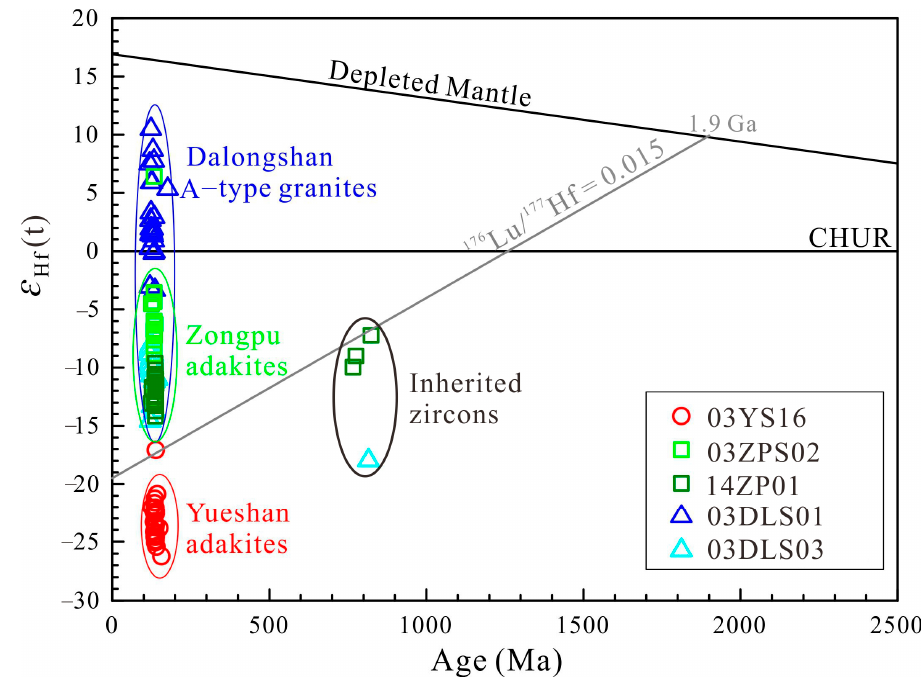
Figure 15. Zircon ε Hf (t) values vs. 206 Pb/ 238 U ages diagram for the Yueshan-Zongpu adakites and the Dalongshan granites in the Anqing orefield. Depleted mantle and CHUR (chondrite uniform reservoir) have been defined in Section 3.3.